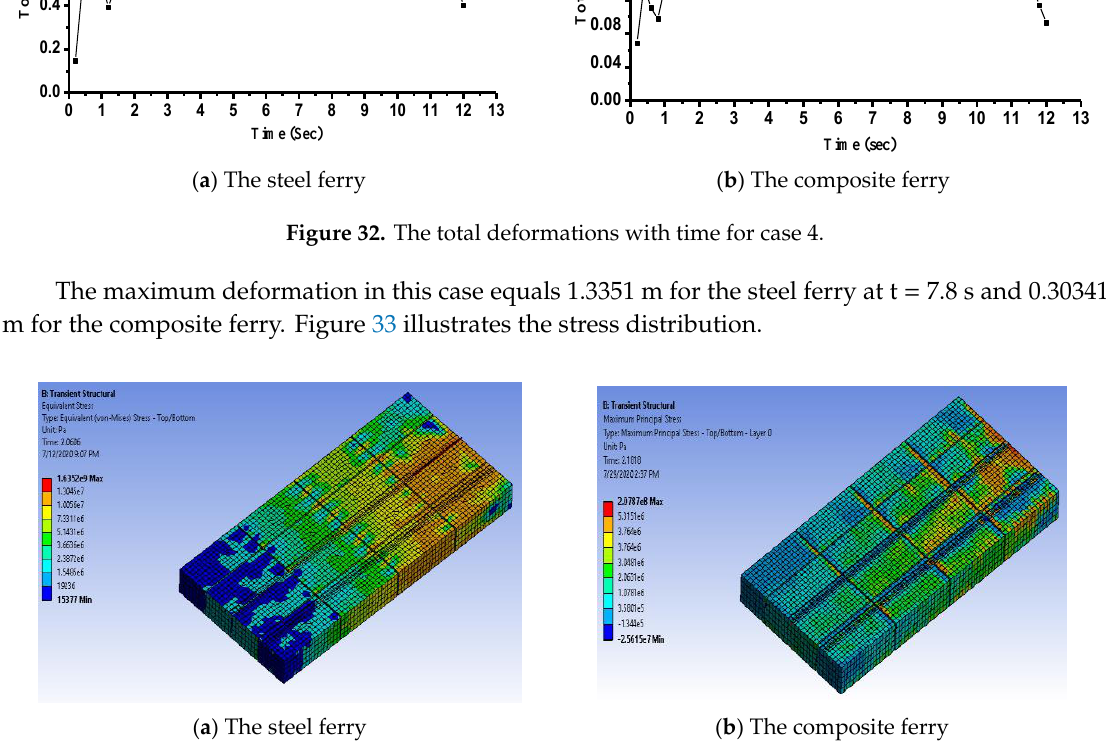
Figure 33. von-Mises stress distribution for case 4.